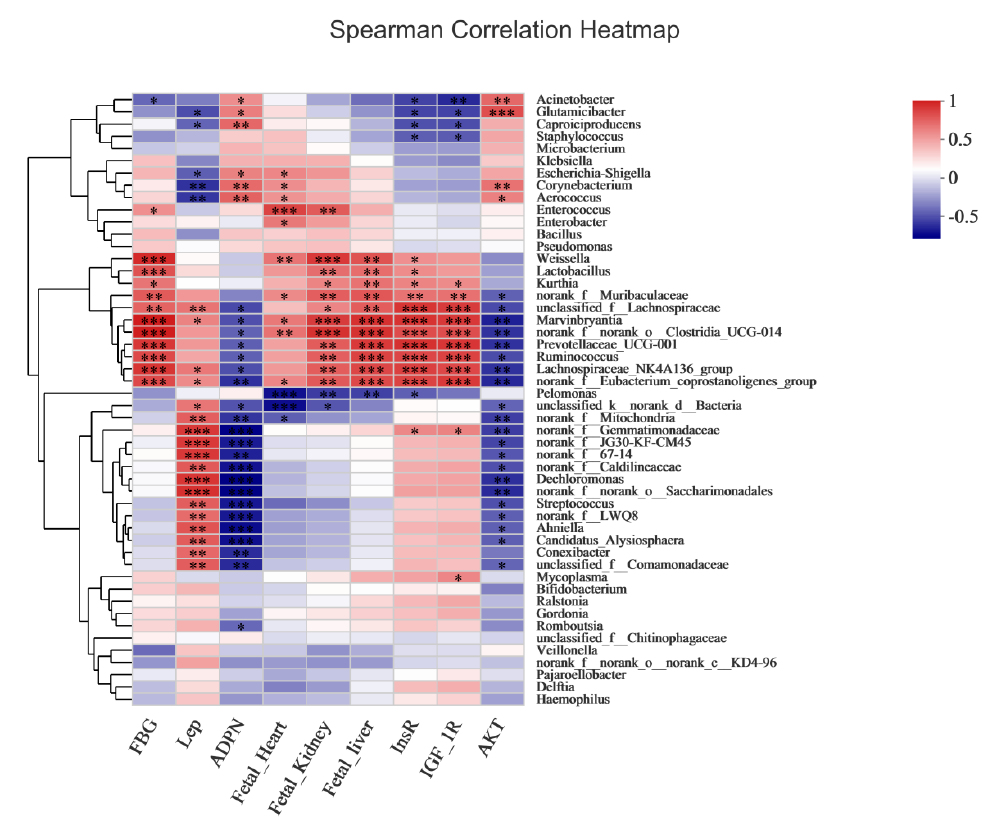
Figure 10. Correlation of placental microbiota structure with maternal and fetal rats’ parameters by Spearman correlation heatmap. Fasting blood glucose (FBG), HbA1c levels (HbA1c), triglycerides (TG), total cholesterol (TCHO), insulin (Ins), leptin (Lep), adiponectin (ADPN), insulin receptor (InsR), insulin-like growth factor-1 receptor (IGF-1R), and protein kinase B (AKT); * p < 0.05, ** p < 0.01, and *** p < 0.001.